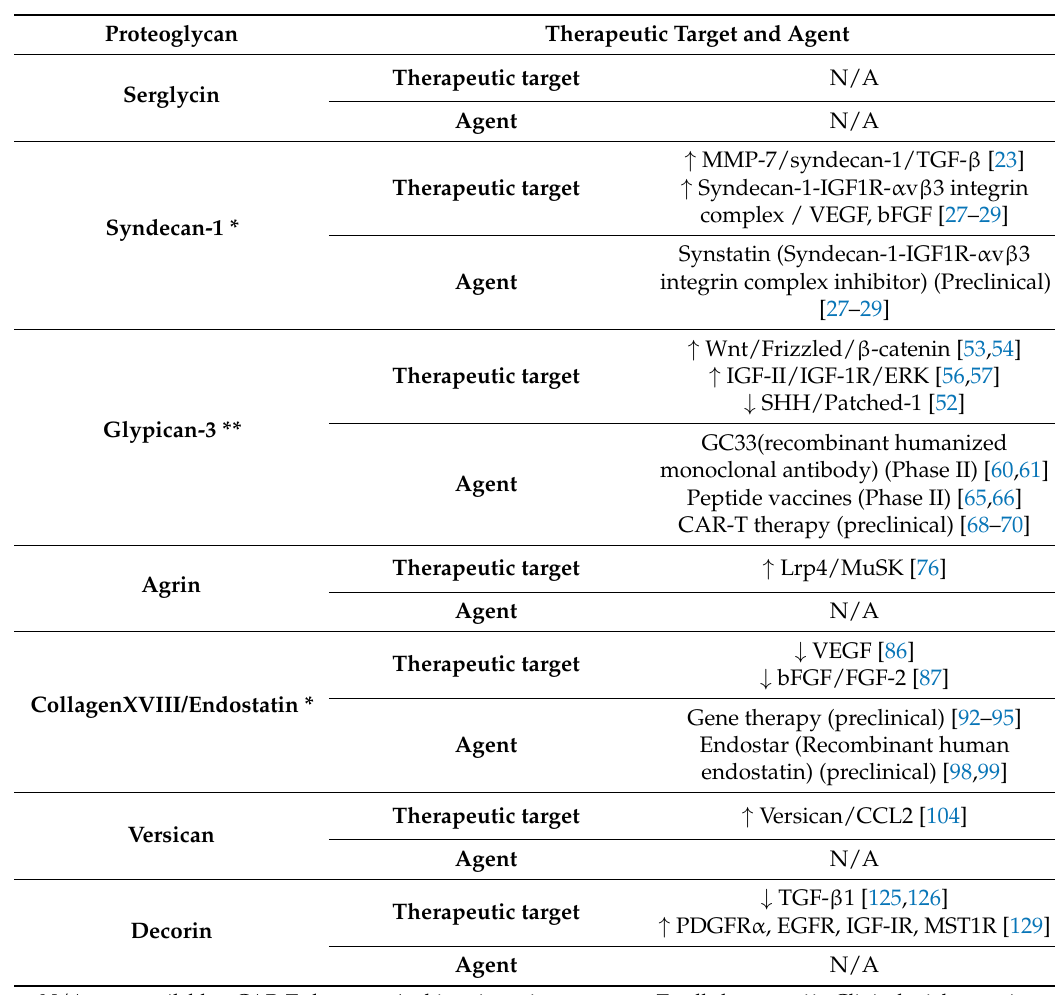
Table 3. Proteoglycans as therapeutic targets in liver